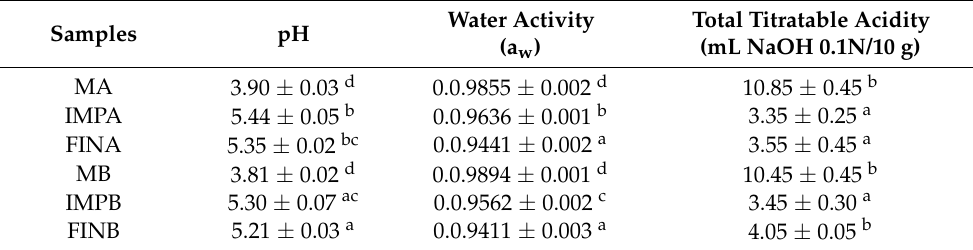
Table 1. Physicochemical parameters detected on the samples collected during the Panettone production.